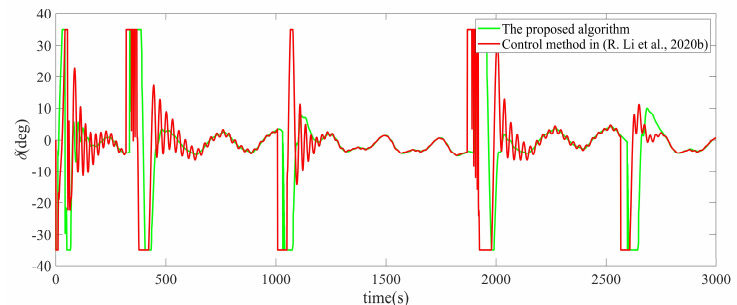
Figure 6. Comparison of course angle: proposed algorithm and control method in [32].